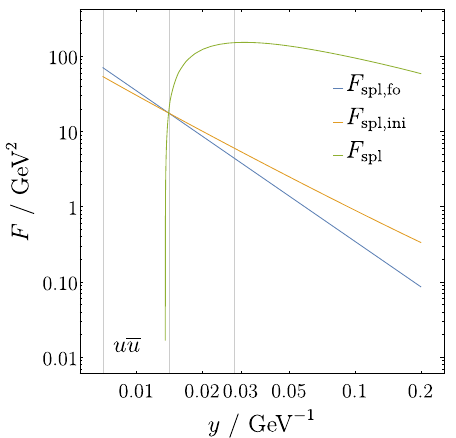
Figure 18 . As figure 14a but for asymmetric kinematics x 1 = 10 − 4 , x 2 = 0 . 31 at µ = 80 GeV, which is needed for the point Y = 4 in figure